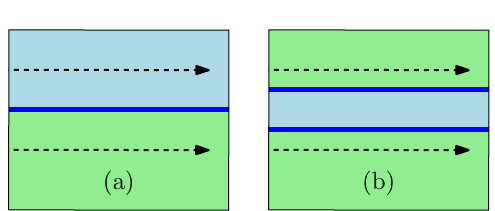
Figure 2: Trajectories (in dashed, black) distinguished by geographic context (boundaries shown in bold,